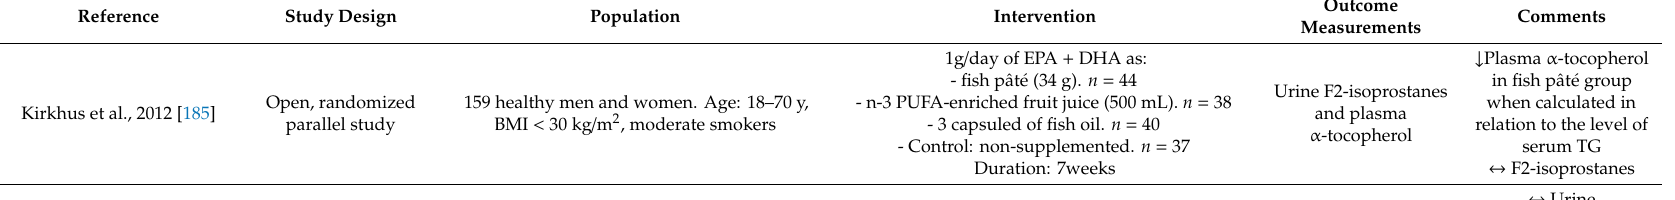
↓ Plasma F2-isoprostanes with